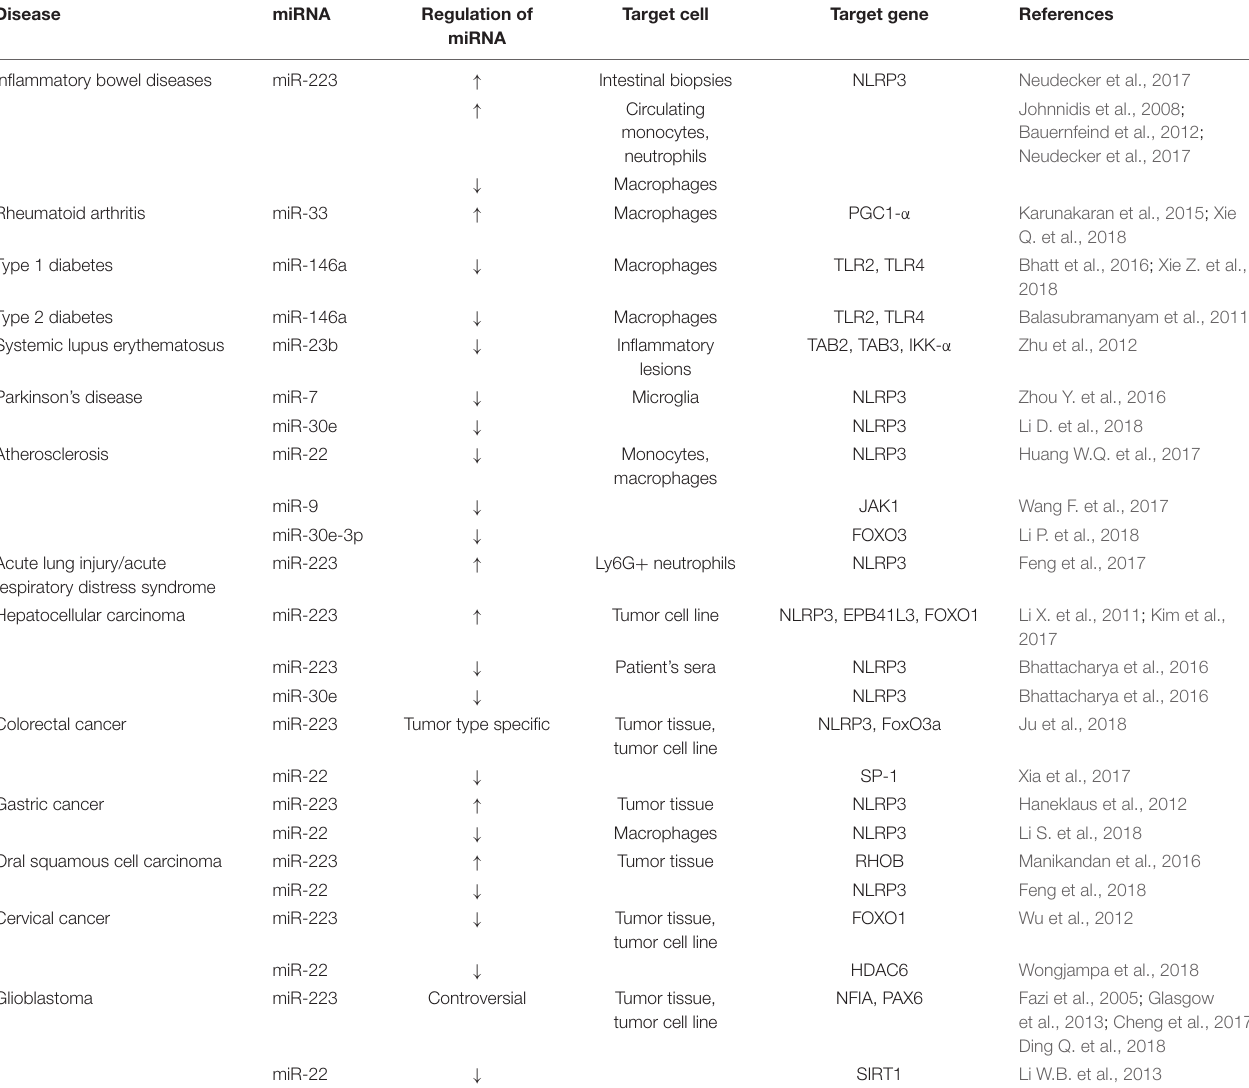
TABLE 1 | Aberrant miRNA expressions linked to inflammasome related